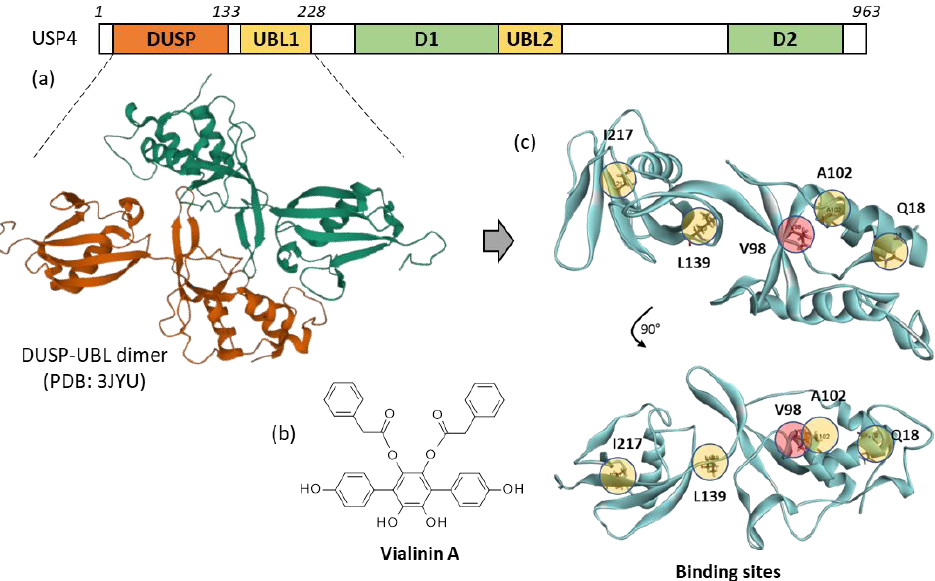
Figure 1. USP4 protein and vialinin binding sites. ( a ) Schematic illustration of the domain organi- zation of USP4, with the domain in USP segment (DUSP), the ubiquitin-like domains (UBL 1 and UBL2) and the domain 1 (D1) and domain 2 (D2) separated by a UBL-containing insert (adapted from Hu et al., 2021). A molecular model of the DUSP-UBL dimer structure of USP4 is shown (from PDB: 3JYU). ( b ) Chemical structure of vialinin A. ( c ) A molecular model of monomeric USP4 with the potential binding sites for vialinin A. Five potential binding sites were identified using the web server CASTp 3.0. The energies of interaction ( ∆ E) calculated at each site ranked in the order V98 > L139 > Q18 > I217, I102. Site V98 (pointed out in red) was selected for subsequent analyses with Vi-A and analogues.